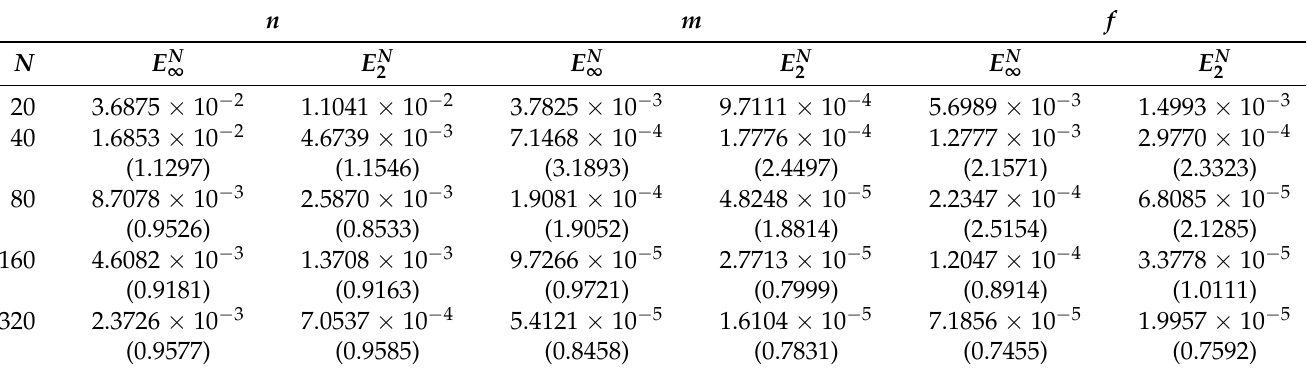
Table 9. Errors and convergence rates (bracketed) in different norms, Example